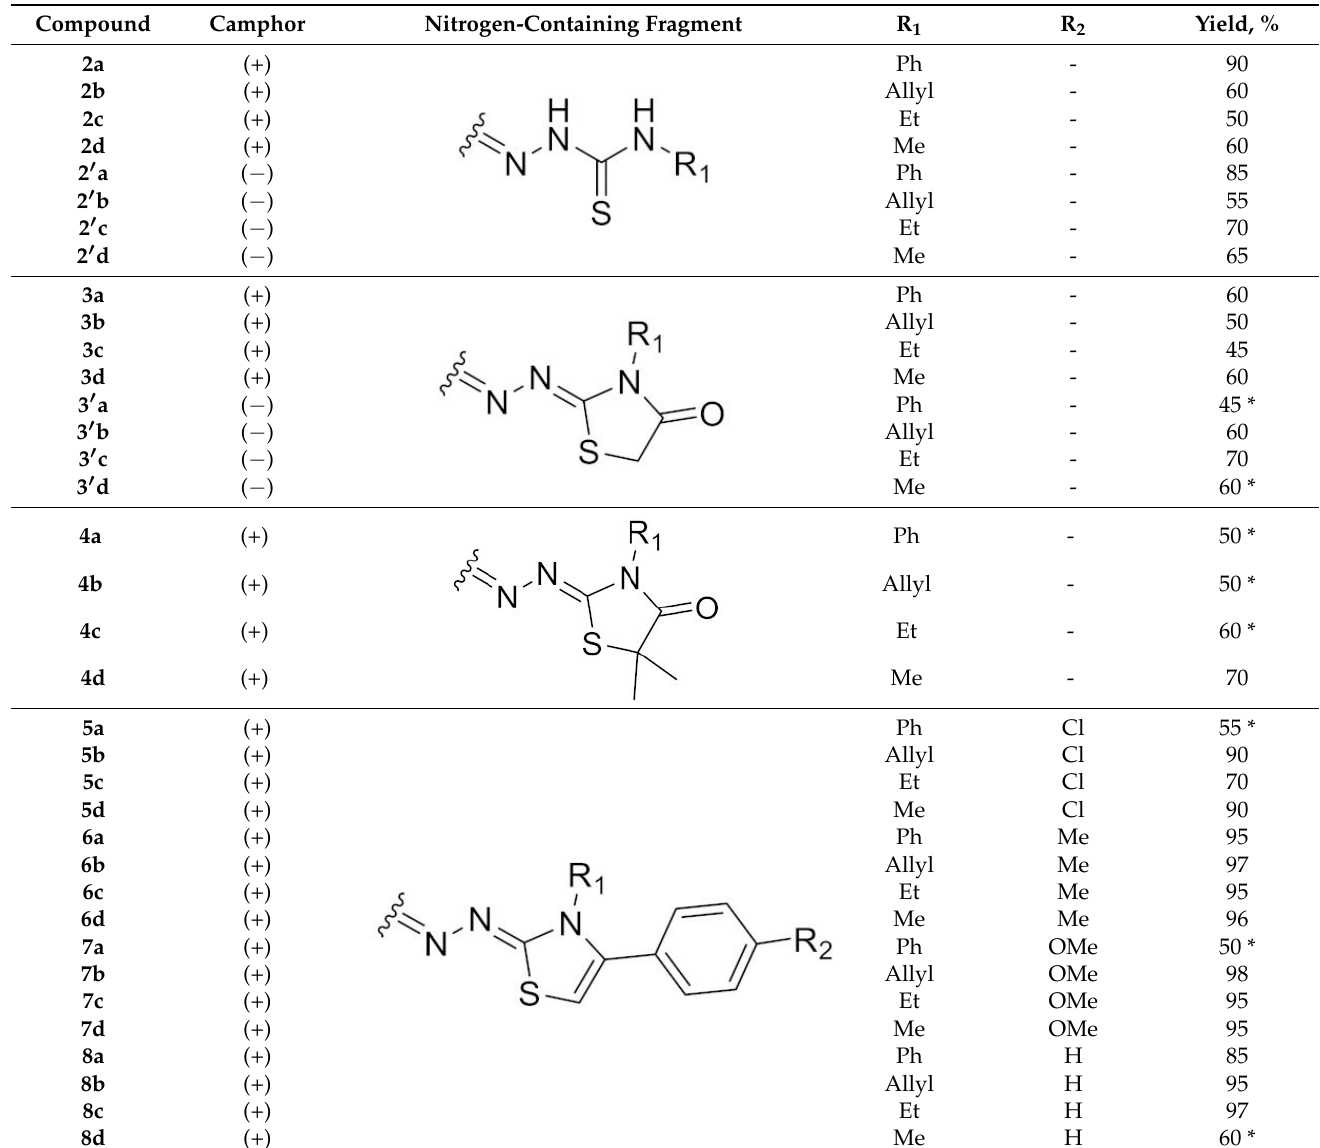
Table 1. Structures of synthesized compounds and reaction